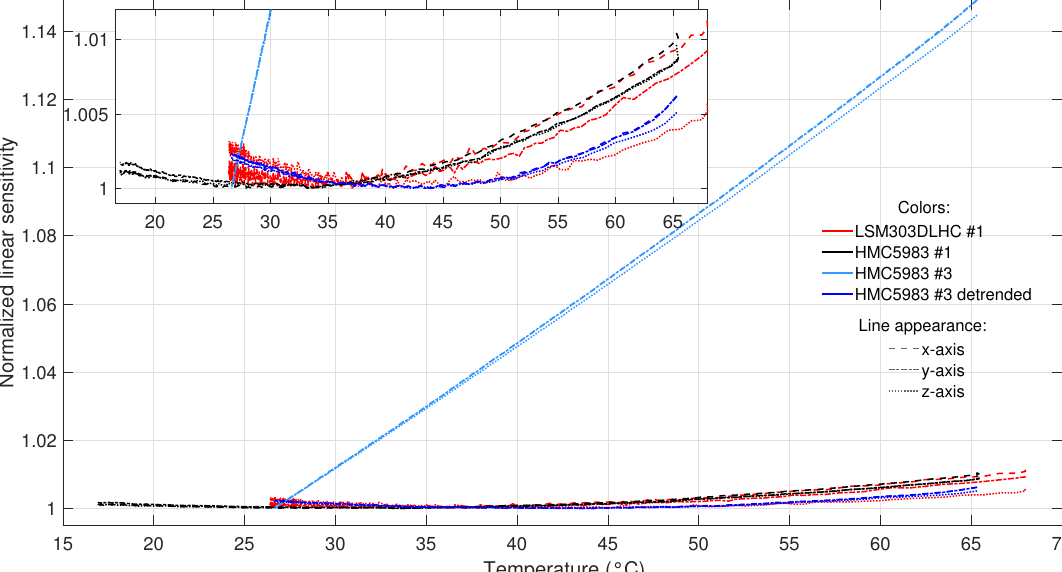
Figure 7. Sensitivity temperature dependency for the LSM303DLHC #1 and HMC5983 #1 and #3. The different sensors are represented by different colors, and the x-, y-, and z-axes by dashed, dashed-dotted, and dotted lines, respectively. The HMC5983 #3 had no internal temperature compensation and shows a linear dependency (light blue lines). For this sensor, additional courses (dark blue lines) with the linear trend subtracted (‘detrended’) are also shown. The remaining sensitivity course can be approximated by a second-order polynomial as in the other shown sensors, which is magnified in the